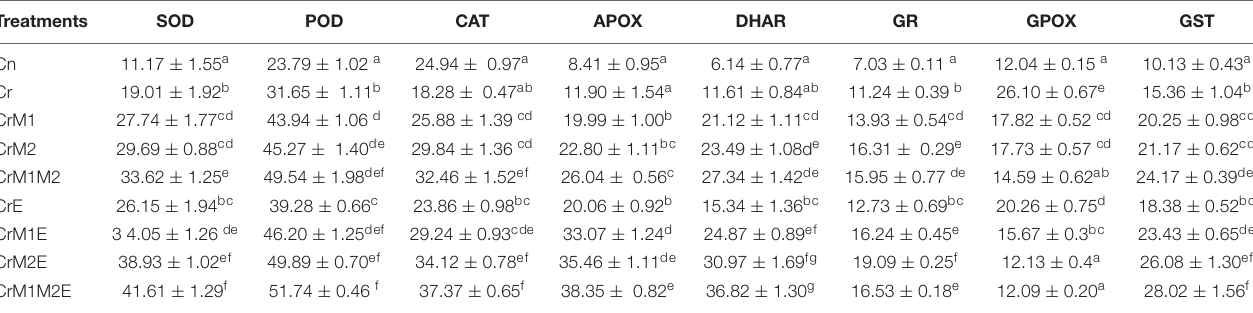
TABLE 2 | Effect of PGPR [ Pseudomonas aeruginosa (M1) & Burkholderia gladioli (M2)] and the earthworms [ Eisenia fetida (E)] on the activity of SOD, POD, CAT, APOX, DHAR, GR,GPOX, GST in 10 day old B. juncea seedlings under chromium (Cr) toxicity. Treatments SOD POD CAT APOX DHAR GR GPOX